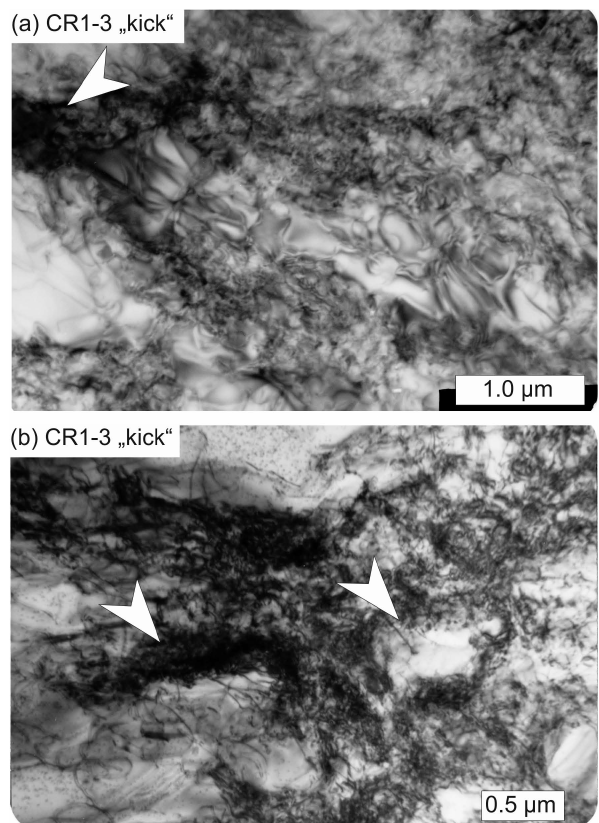
Fig. 4. TEM bright field micrographs of quartz from “kick” exper- iment CR-1-3 performed at 400 ◦ C, 2GPa confining pressure, and strain rate of 10 − 4 s − 1 , being exceedingly prone to radiation dam- age. (a, b) TEM micrographs from FIB cut foil located in Fig. 3a (“kick” experiment CR1-3). Quartz shows dislocation tangles and domains poor in dislocations bound by tangles and dislocation walls (arrows), referred to as cellular